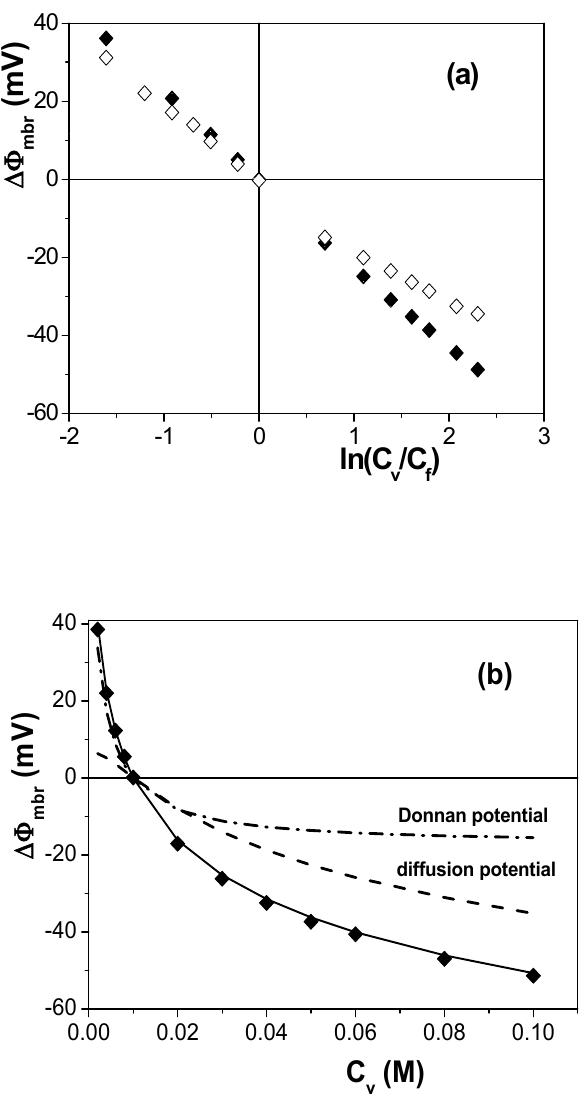
Figure 6. ( a ) Comparison of membrane potential with solution concentration ratio for Ox- NPAM/TiO 2 ( ◊ ) and Ox-NPAM/TiO 2 (f) ( ♦ ) membranes. ( b ) Comparison of experimental and calculated (solid line) values, Donnan (dashed-dot line), and diffusion (dashed line) potential contri- butions for Ox-NPAM/TiO 2 (f) membrane.